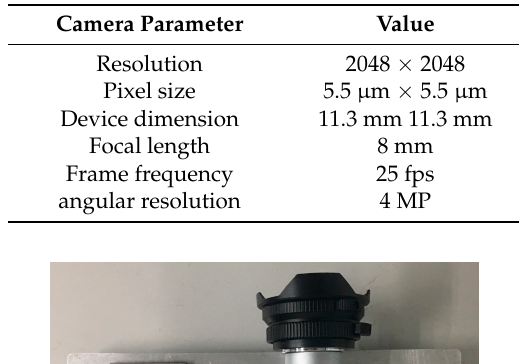
Table 2. Camera parameters of the Basler acA2040-25gm camera in System 2.